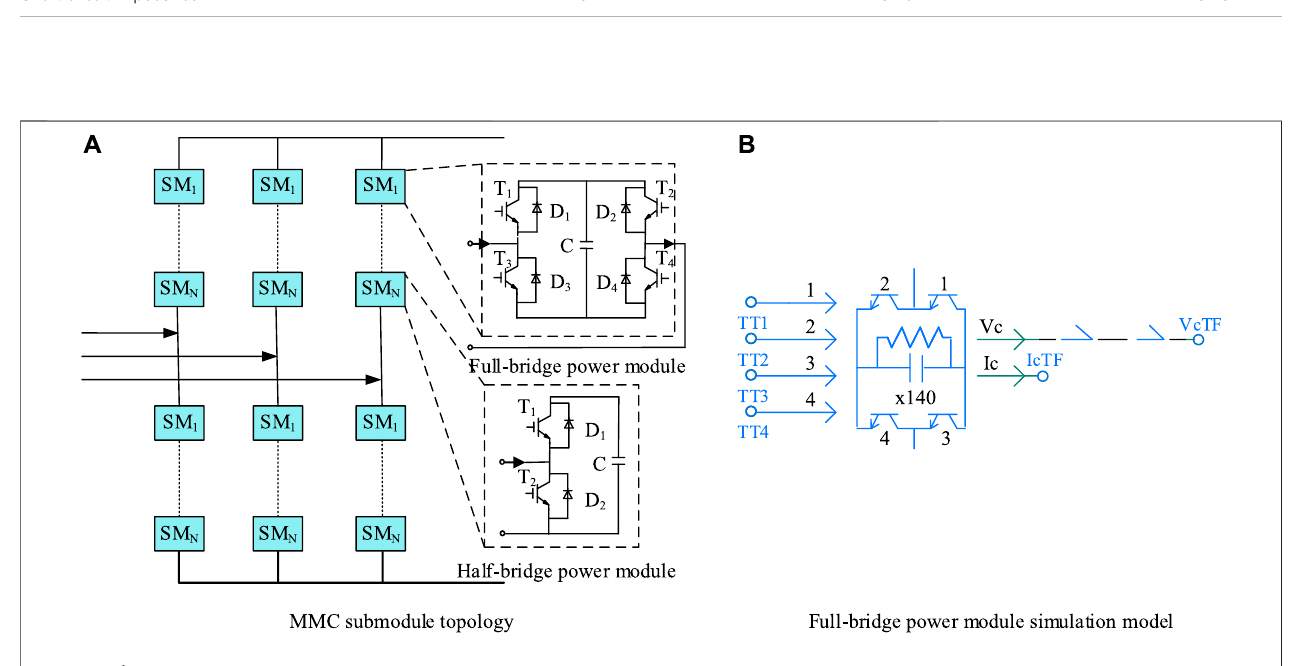
FIGURE 3 | MMC submodule topology and full-bridge power module simulation